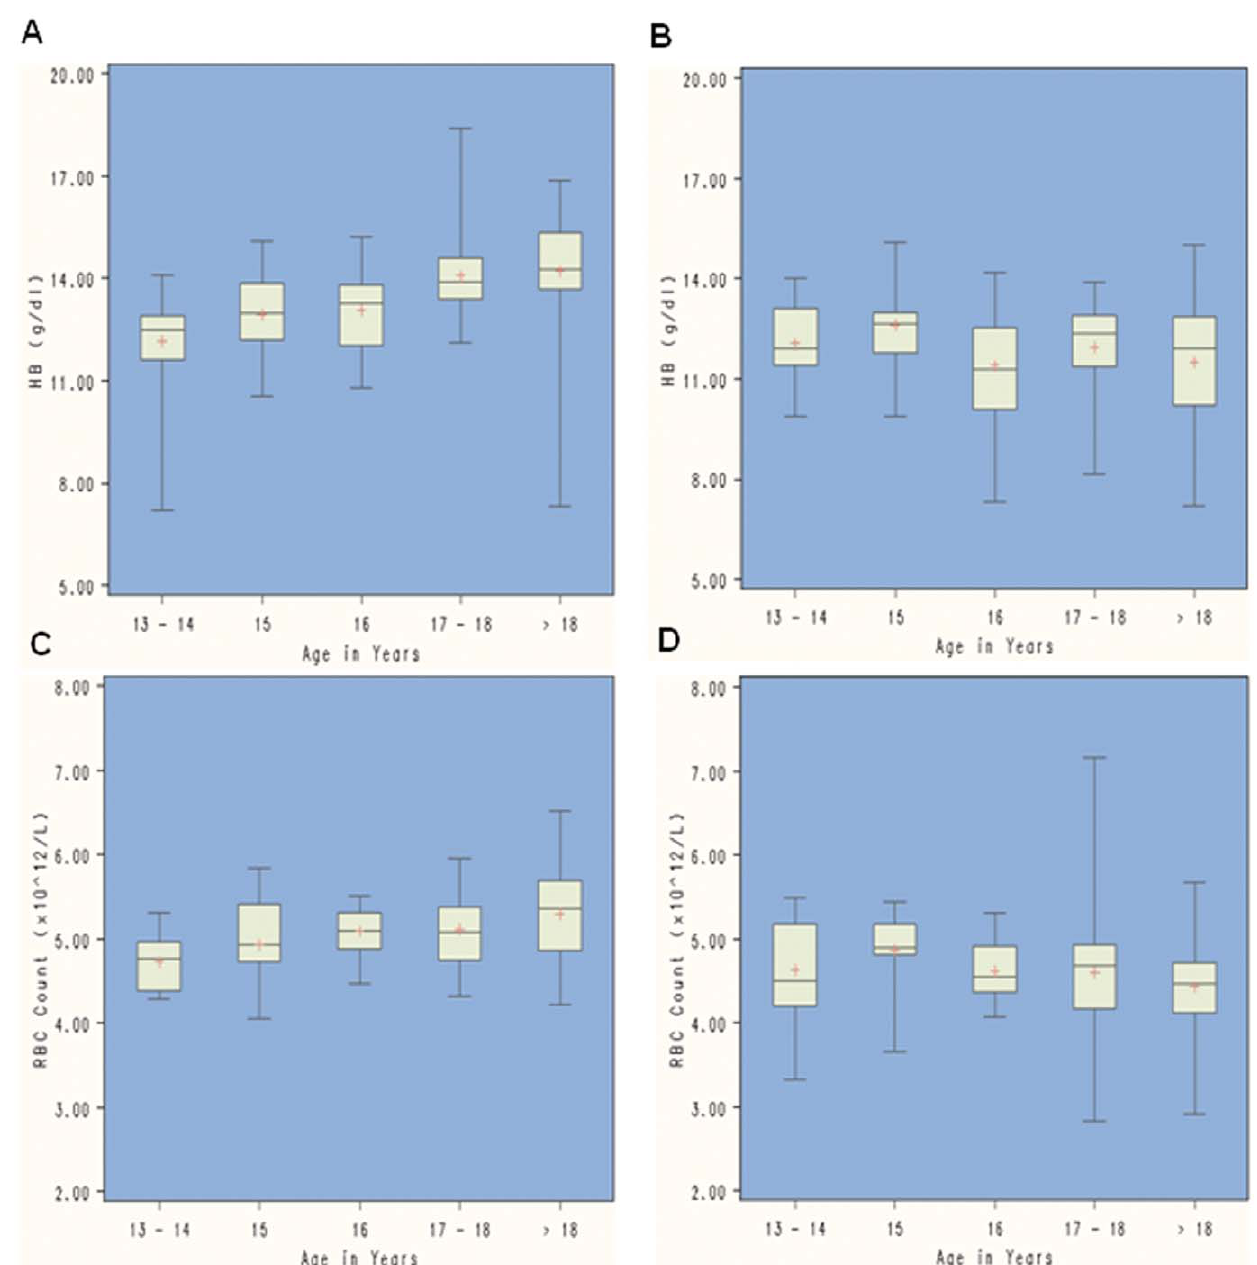
Figure 1. Box and whisker plots showing variation in hematological values with age and gender. Hemoglobin (A and B) and Red Blood Cell count (C and D) variation with age in both males (left panel) and females (right panel) from rural western Kenya.